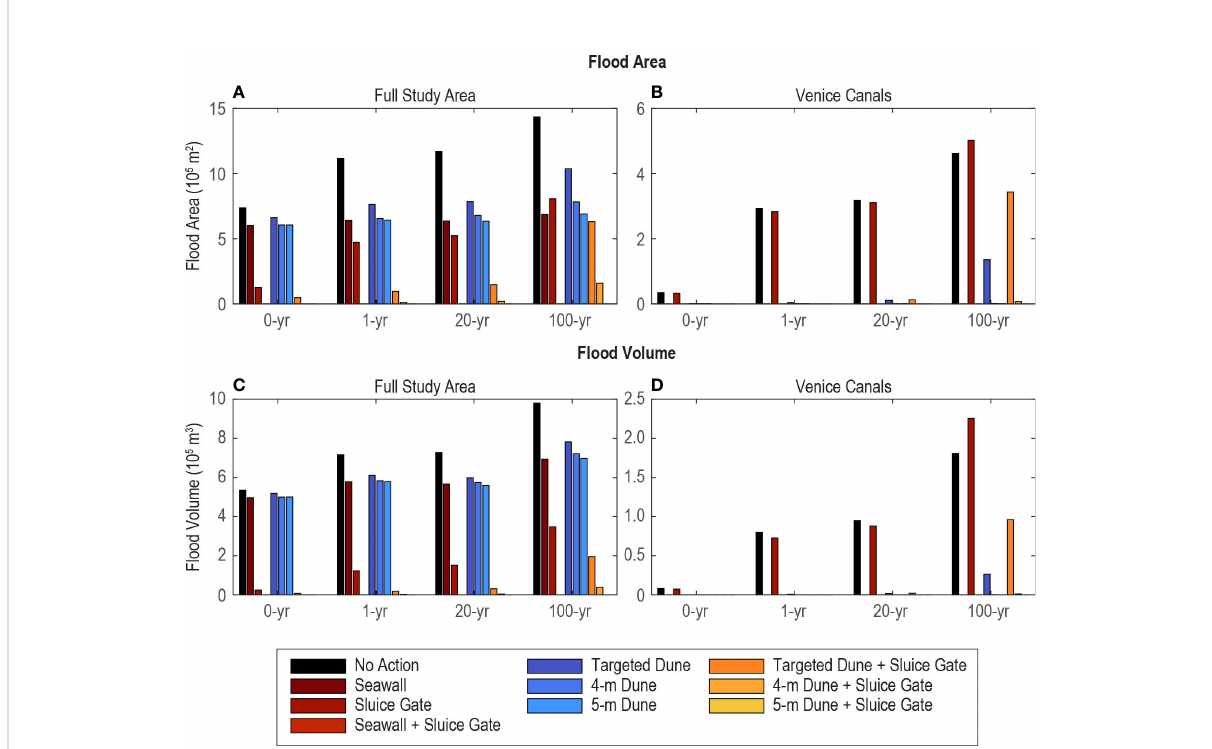
FIGURE 3 Simulated fl ood area (A, B) and volume (C, D) for each adaptation approach across the range of storm scenarios. Results for the full study area are shown in the left column and the Venice Canals in the right column with bar colors represented by the adaptation approaches. Where bars are not visible, minimal or no fl ooding was